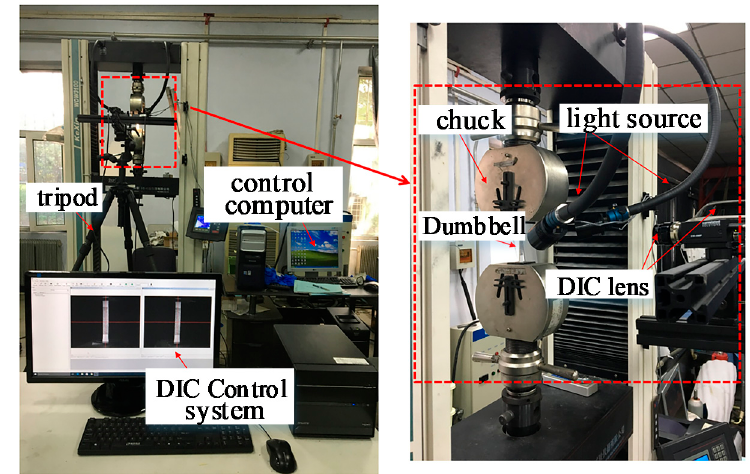
Figure 8. VIC-3D measurement system.